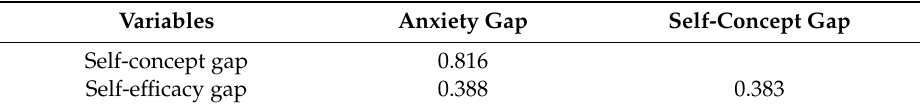
Table A8. Cross-correlation